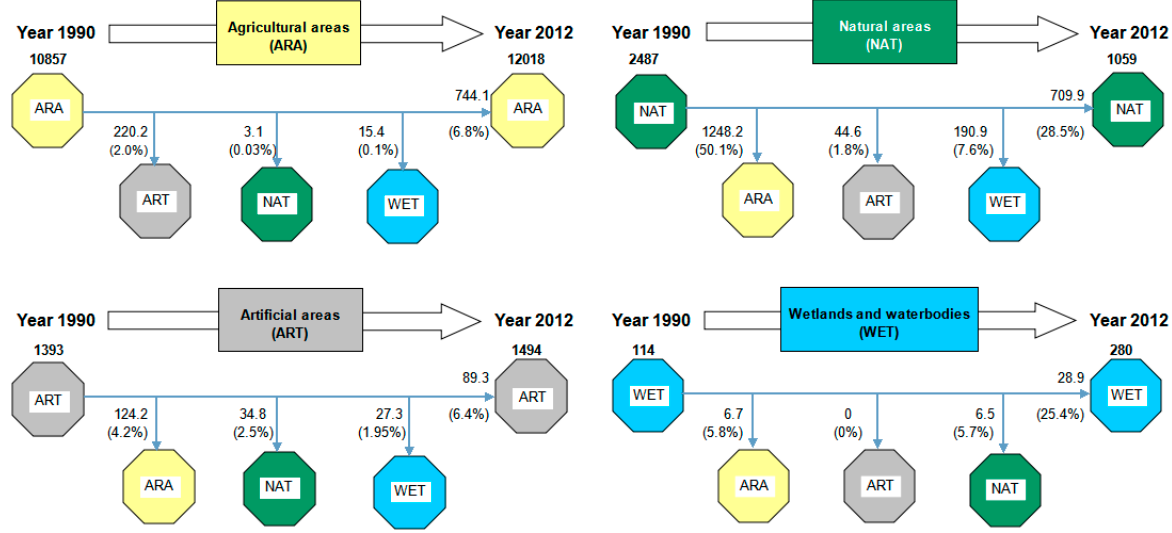
Figure 3. Sicily. Detected land-cover / land-use changes (in hectares) in the 2-km buffer areas around 16 main wetlands during 1990–2012, separately for agricultural areas (ARA), artificial areas (ART), natural areas (NAT) and wetlands/waterbodies (WET).